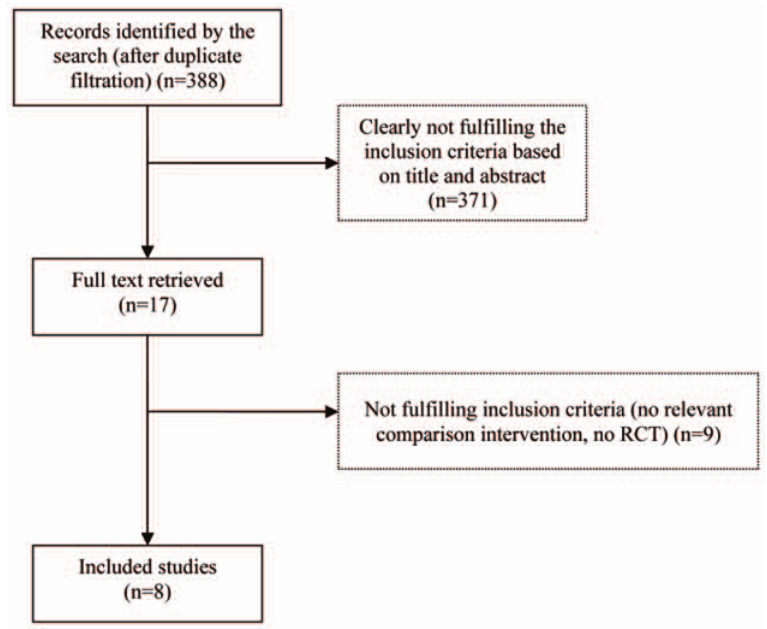
Figure 1. Flow chart of search results.